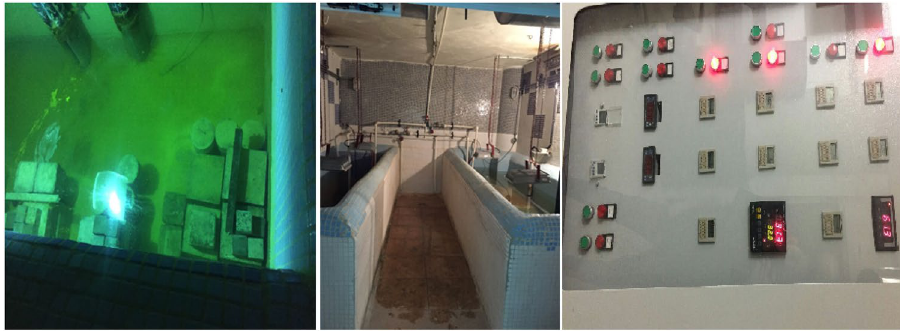
Fig. 6 The interior view of the marine simulator environment